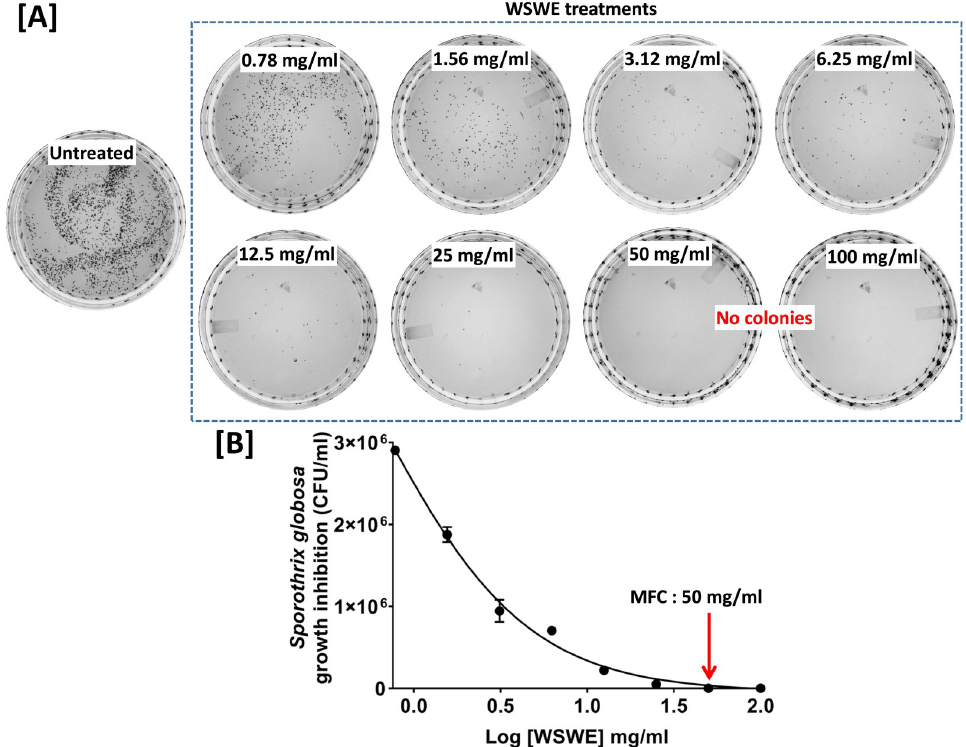
Fig 2. Determination of minimum fungicidal concentration of WSWE against S . globosa . [A] Representative plate images showing the effect of different concentrations of WSWE on the number of visible colonies of S . globosa on agar plates. Absence of visible colonies is indicated. [B] Line graph of CFU/ml versus log concentrations of WSWE, quantitatively representing the data shown in (A), with the minimum fungicidal concentration (MFC) indicated with red